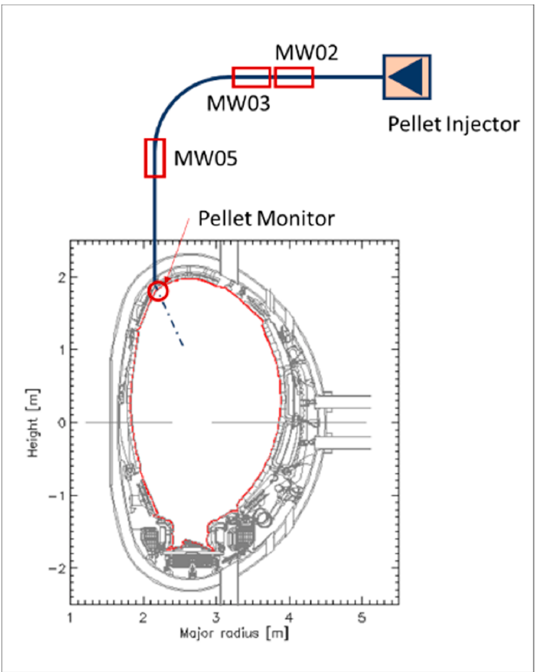
Figure 1. Pellet injection schematics (configuration post-2015).